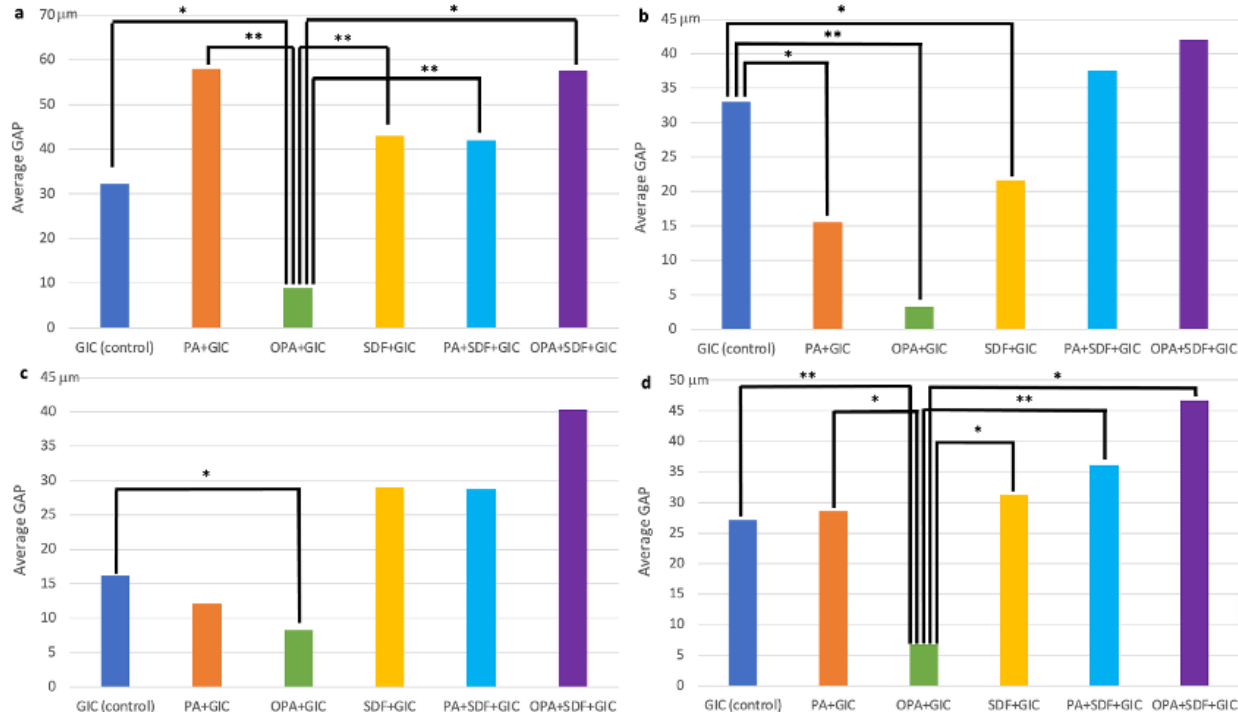
Figure 3. Gap size comparison between the study subgroups. ( a ) Coronal wall, ( b ) axial wall, ( c ) cervical wall, ( d ) mean. Statistically significant differences are indicated with an asterisk: * p < 0.05; ** p < 0.01.